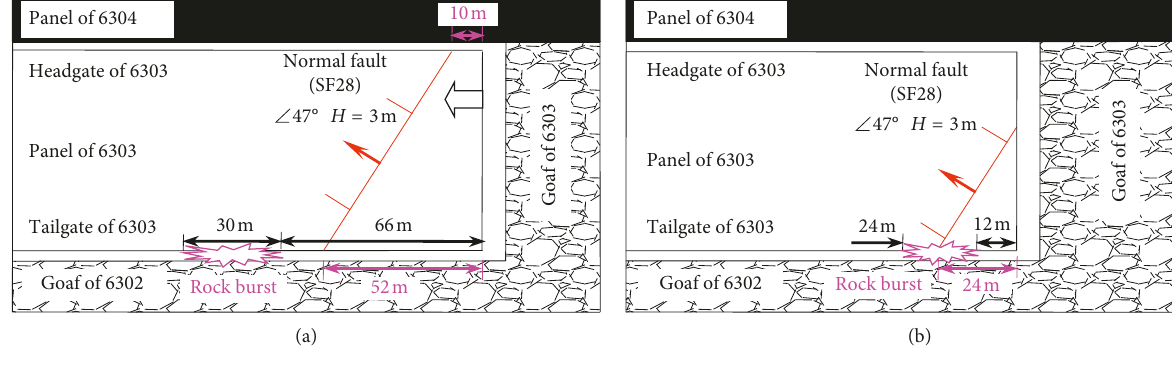
Figure 10: Rock burst accidents of panel